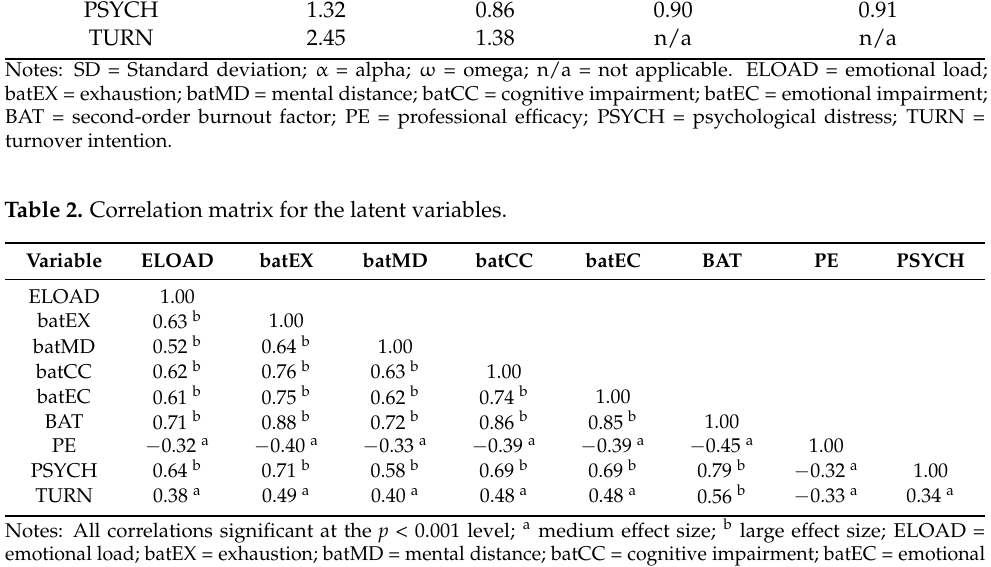
Table 1 provides the descriptive statistics with reliability coefficients and Table 2